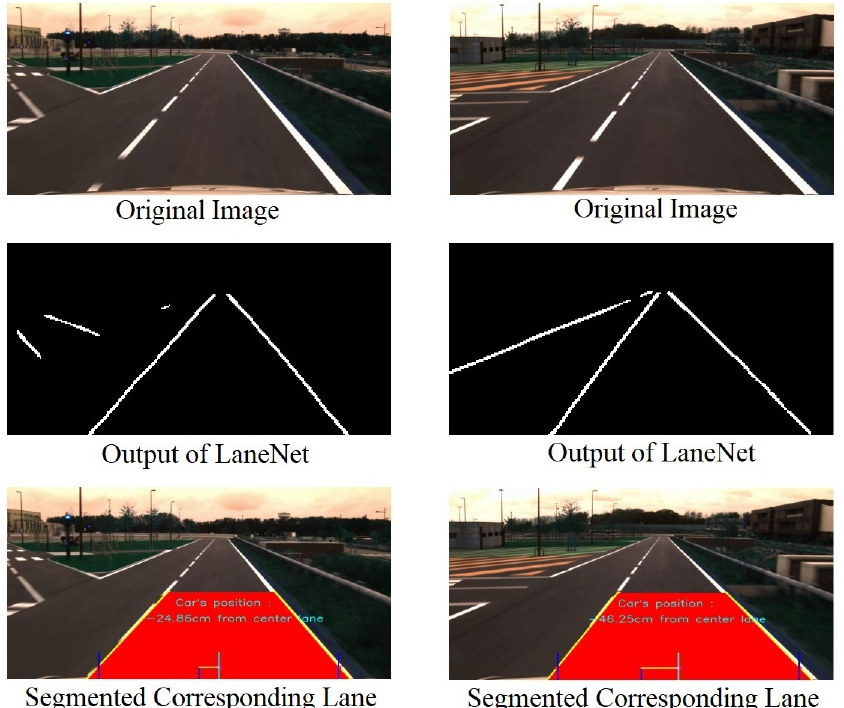
Figure 5. Process of finding the corresponding road